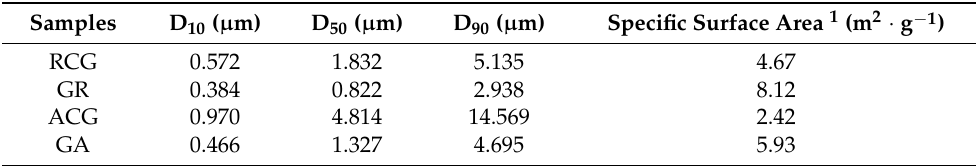
Table 3. Main particle size parameters and specific surface area of coal gangue before and after grinding.